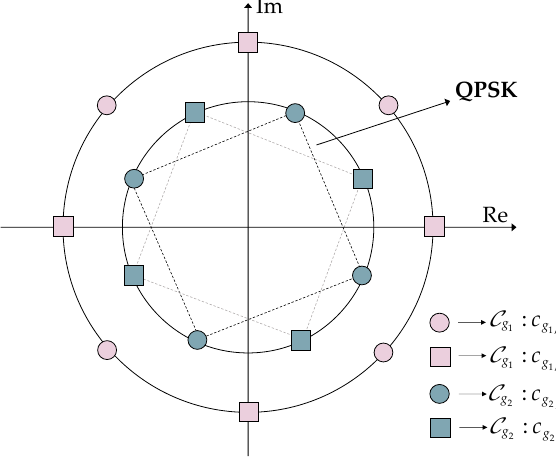
Figure 3. Codebooks of multi-user group on the kth resource.